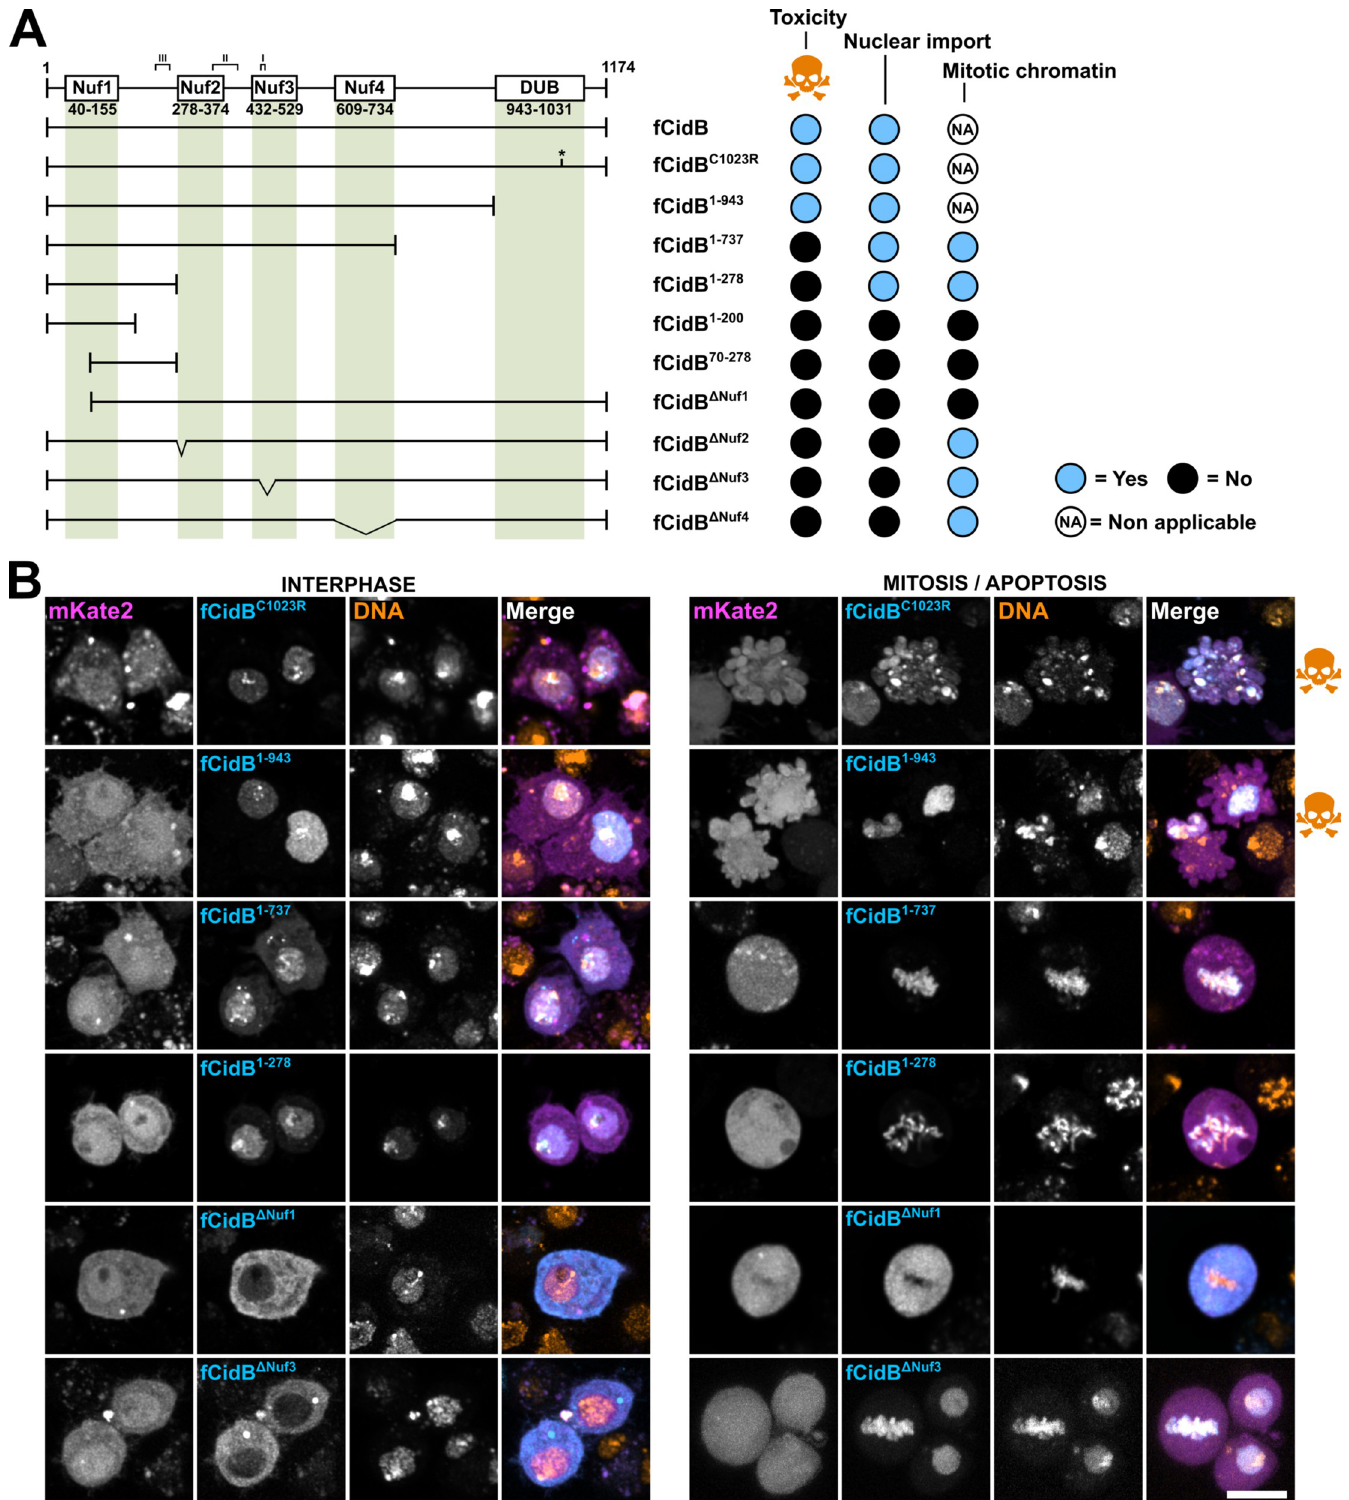
Fig 3. Structure-function analysis of CidB. (A) Schematic representation of CidB with its previously identified domains, together with the various deletion mutants tested and associated phenotypes. When CidB or its mutants are toxic and prevent mitosis, the localization to the mitotic chromatin is non applicable. (B) Confocal images of S2R + cells transfected with fCidB mutants showing the subcellular localization in interphase and its outcome illustrated either by mitotic figures or apoptotic events -blebbing cells with fragmented DNA, skull and crossbones symbol-. CidB mutants are in cyan, free mkate2 in magenta and DNA -Hoechst- in yellow.Scale bar = 10 μ m. https://doi.org/10.1371/journal.ppat.1011211.g003 PLOS Pathogens| https://doi.org/10.1371/journal.ppat.1011211 March 16,